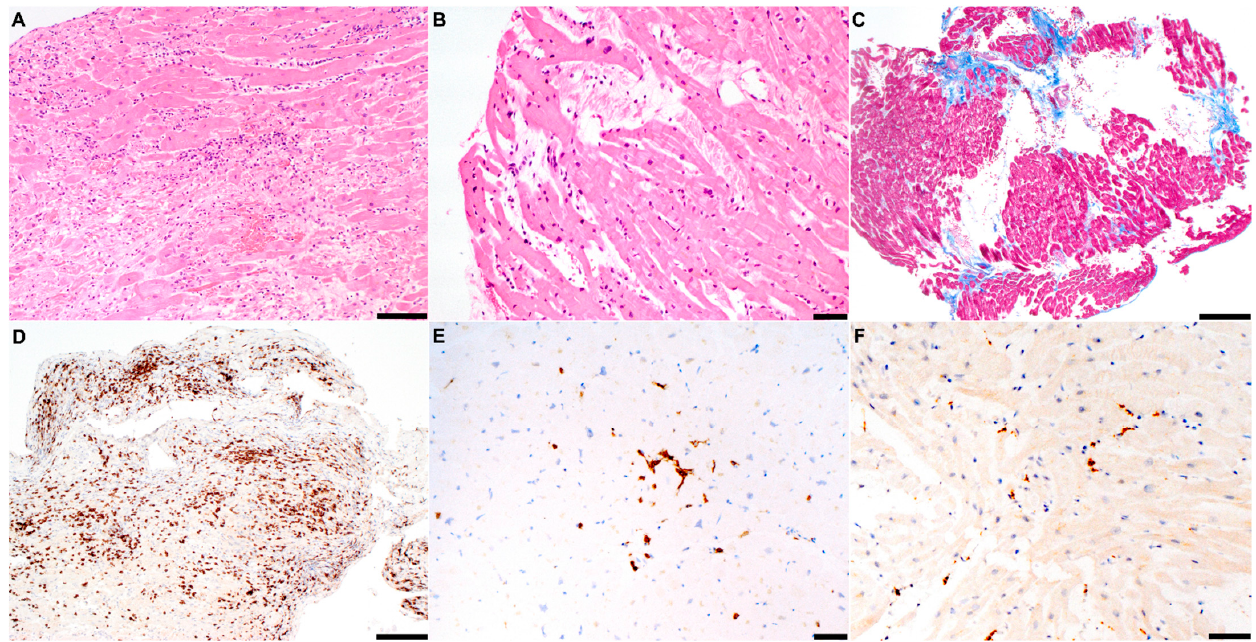
Figure 3. Histology findings. Representative findings at histologic analysis of patients (P1–P7) are shown. ( A ) Hematoxylin-eosin assay in a patient (P7) with fulminant EBV myocarditis complicating COVID-19 infection; diffuse areas of necrosis and massive lymphocytic inflammatory infiltrates are shown; ( B ) mild lymphocytic infiltration without significant necrosis in a patient (P1) with borderline myocarditis; ( C ) trichrome assay in a patient (P6) with myocarditis (not shown) and likely preexisting dilated cardiomyopathy; multiple areas of replacement fibrosis (blue) are shown; ( D ) immunohistochemistry for CD3+ T-lymphocytes (>> 7/mm2) in fulminant myocarditis (P7); ( E ) in contrast, milder CD3+ infiltrated in a patient with mild inflammatory cardiomyopathy (P5); ( F ) CD68+ macrophage infiltrates in a patient with SARS-CoV-2 borderline myocarditis (P2). Scale bars: A: 100 µm; B,E,F: 50 µm; C,D: 200 µm. CD = cluster of differentiation; EBV = Epstein–Barr virus; SARS-CoV2 = severe acute respiratory syndrome coronavirus-2.